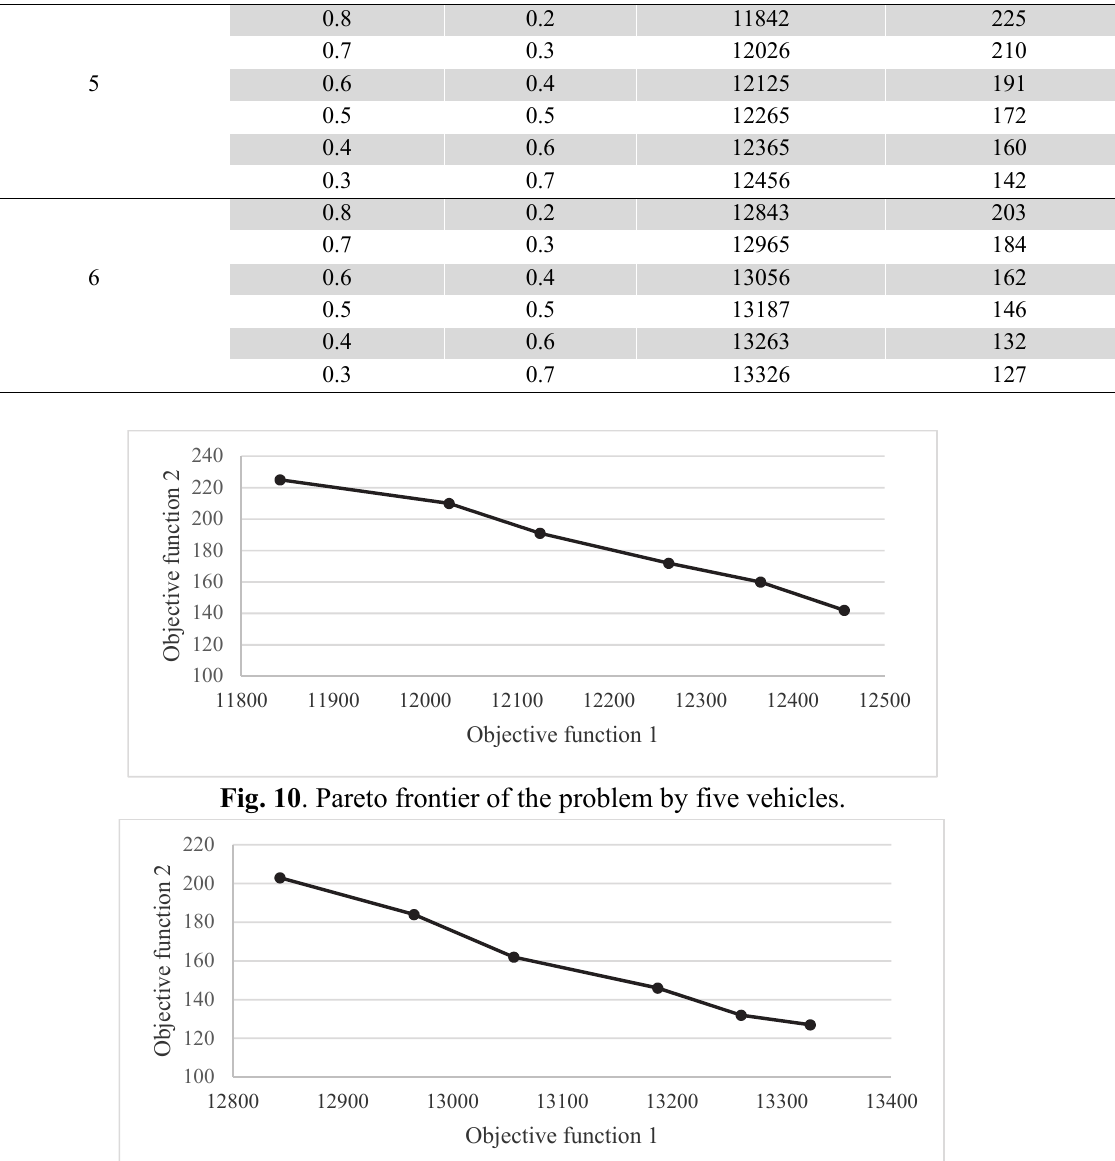
Objective function Fig. 11 . Pareto frontier of the problem by six vehicles.